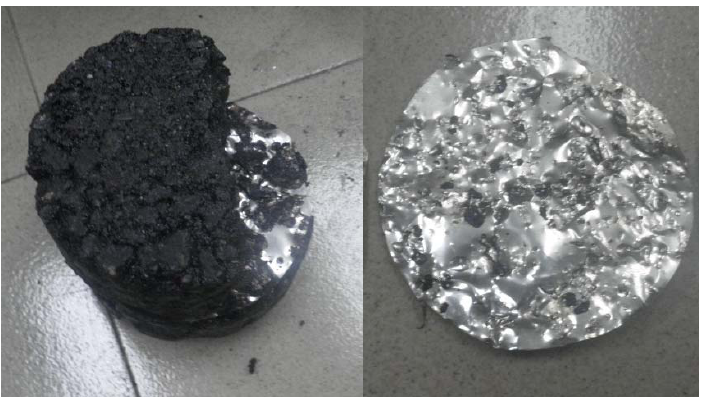
Figure 3. Illustration of the aluminum slice between upper and lower layer of asphalt mixture.